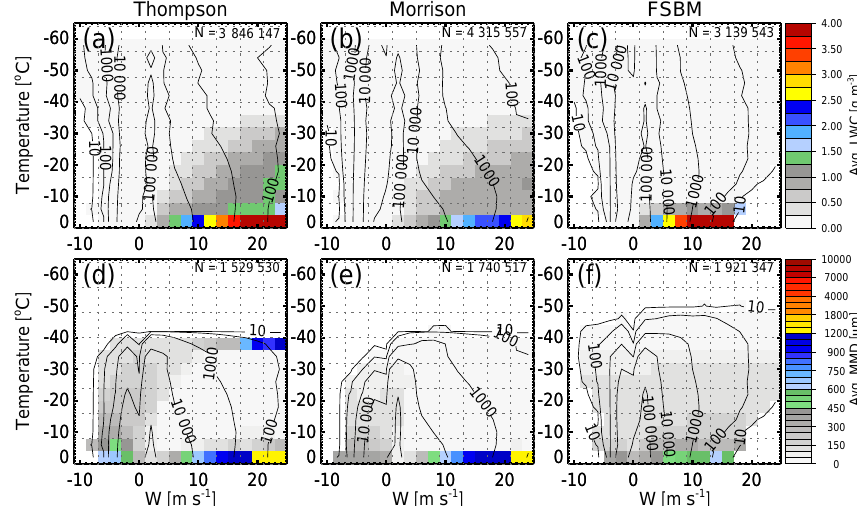
Figure 14. As in Fig. 11, but for liquid water content (LWC) color-filled in (a) – (c) and average liquid MMDs color-filled in (d) – (f) .